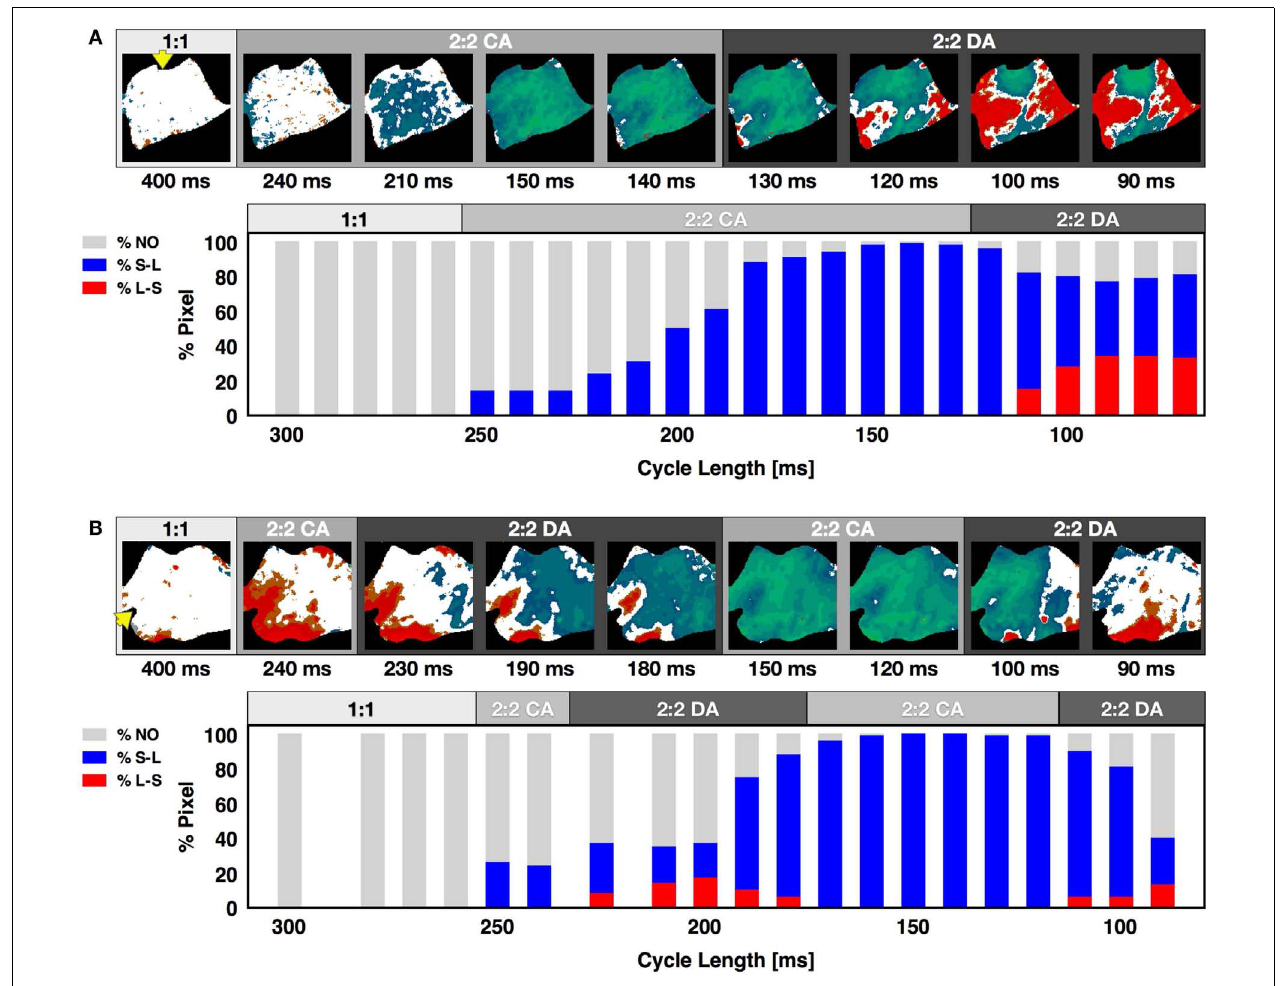
given state at each CL. Gray represents pixels with no alternans, blue pixels alternating short-long, and red pixels alternating long-short; the presence of both red and blue colors indicates discordant alternans. (B) Extended transition from no alternans to concordant alternans to discordant alternans, then back to concordant alternans and discordant alternans.Yellow arrow indicates pacing site.The main axis is